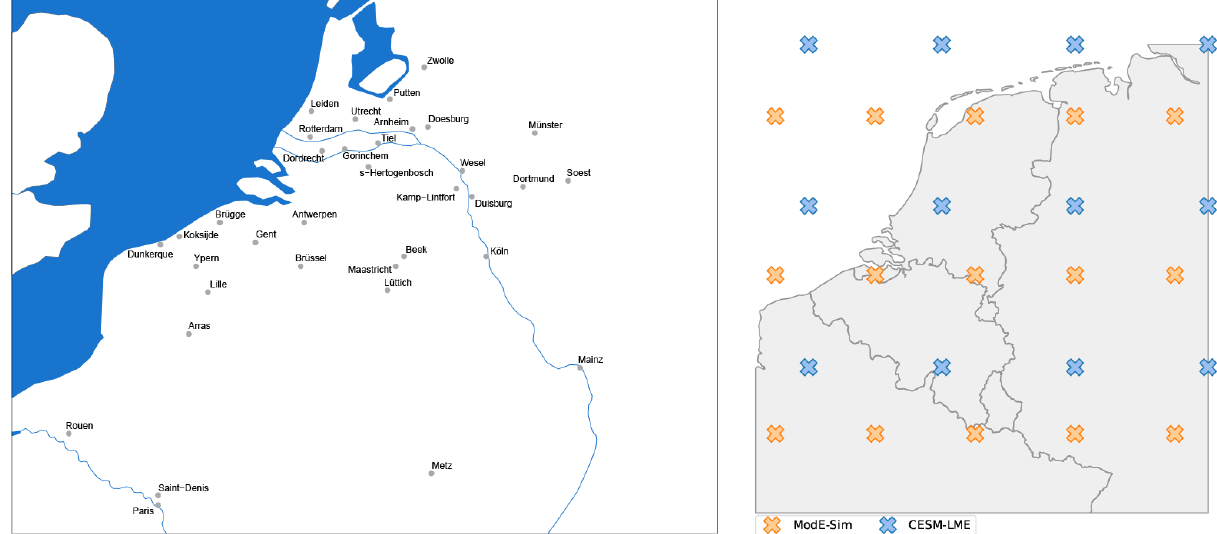
Figure 1. Maps of the Burgundian Low Countries with (left) historical document locations (grey points) describing past climate events during the 15th century and (right) model grid points. The region is defined as the land area delimited by latitudes between 1.5 and 10 ◦ N and longitudes between 48.5 and 54 ◦ E. Orange and blue crosses depict the grid points where temperature and precipitation series have been extracted from the ModE-Sim ensemble and the CESM-LME,